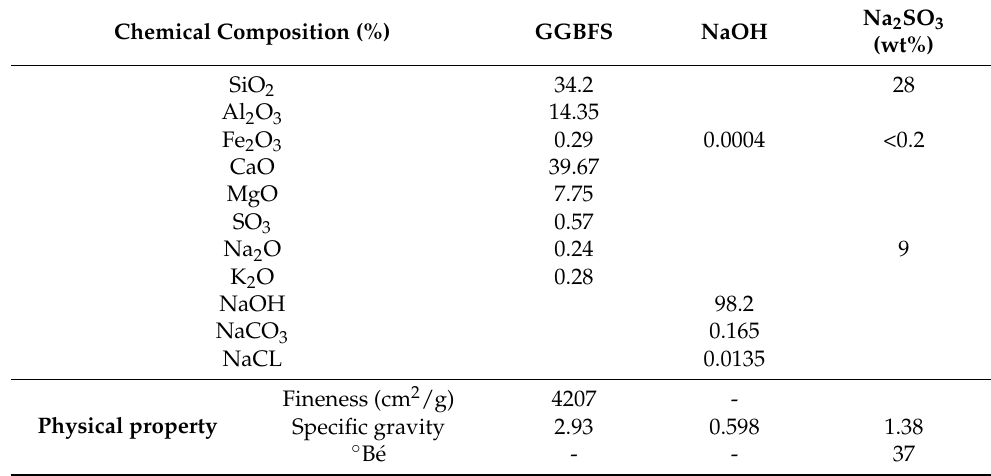
Figure 1. GGBFS. Table 1. Chemical composition and physical properties of the raw materials. Table 1. Chemical composition and physical properties of the raw